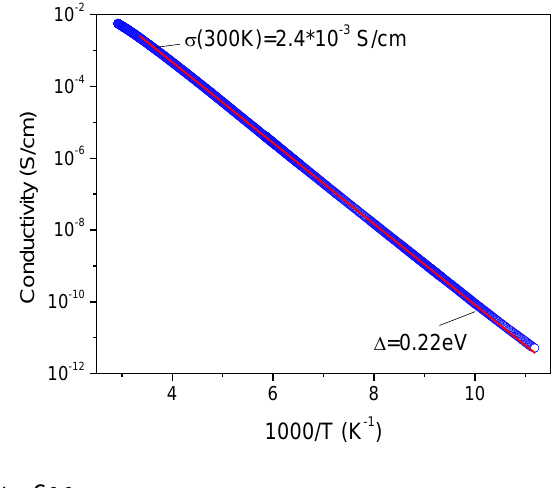
Figure 8. Temperature dependence of conductivity of single crystal of radical 11